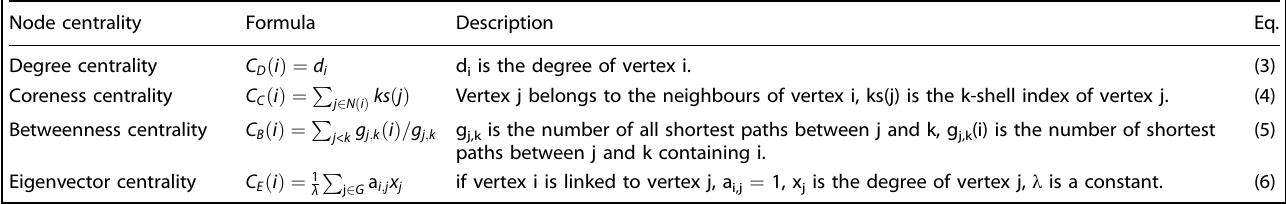
Table 2. The formula to compute degree centrality, coreness centrality, betweenness centrality and eigenvector centrality Node